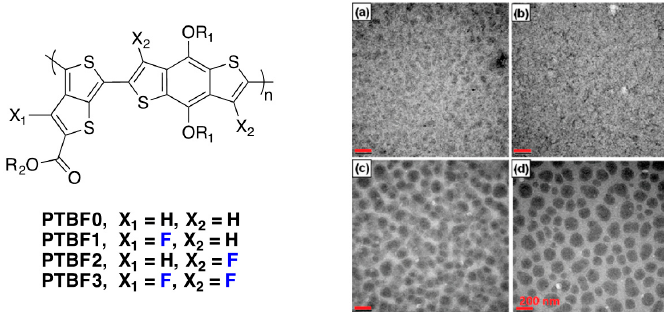
Figure 17. Chemical structures of the investigated polymers ( left ) and TEM images ( right ) of polymer/PC 71 BM films prepared from DCB solvent: PTBF0 ( a ); PTBF1 ( b ); PTBF2 ( c ); and PTBF3 ( d ). Scale bar = 200 nm (adapted with permission from [25]; Copyright 2011 American Chemical Society).